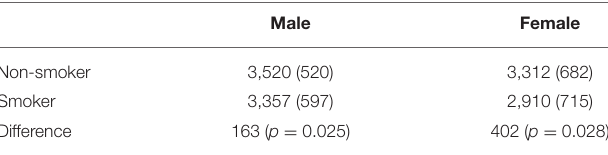
TABLE 1 | Birth weights (g) of term male and female neonates by smoking status of the mother.